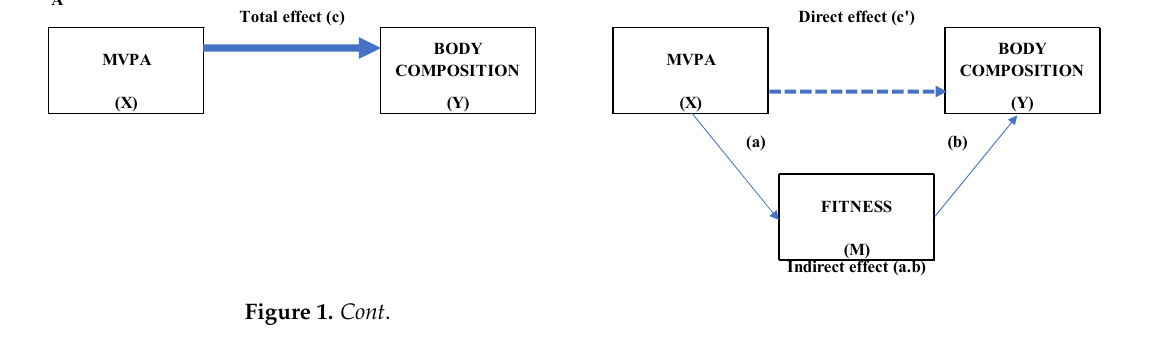
Figure 1. Conceptual models of mediation analysis: indirect effect through fitness ( A ) or kcal ( B ). 3. Results Data for 236 students (59.3% female) aged 16.1 ± 0.92 years that presented valid ac- celerometry data were available for analysis (Table 1). Overall, the bivariate analyses demonstrate consistent small to medium significant relationships between the variables. Regarding body composition, despite 82% of the students presenting with a normal weight, 33% are at high risk according to their body fat. Data from physical fitness assess- ment show that most students were at a low CRF level (71%), and only 23% showed a low muscular fitness level. Triaxial accelerometers data revealed that participants spent an average of 842.4 min per day on sedentary behaviors, 139.6 min per day on light PA, 23.0 min per day on moderate PA, and 13.6 min per day on vigorous PA. Boys had more time on vigorous PA than girls ( p < 0.001). Only 8% of the students performed the recom- mended minutes of MVPA (at least 60 min per day). Regarding body composition and physical fitness, the associations among the study variables showed less correlations for PA below MVPA. Regarding the risk thresholds presented in Table 1, bivariate correlation results showed, for body fat, a negative corre- lation with energy intake (ρ = −0.146, p < 0.05), CRF (ρ = −0.790, p < 0.01), upper body muscle force (ρ = −0.687, p < 0.01), vigorous PA (ρ = −0.400, p < 0.01), and MVPA (ρ = −0.341, p < 0.01). Thus, regarding physical fitness, CRF and strength, respectively, they showed positive correlations with energy intake (ρ = 0.269, p < 0.01; ρ = 0.256, p < 0.01), basal met- abolic rate (ρ = 0.383, p < 0.01; ρ = 0.314, p < 0.01), vigorous PA (ρ = 0.482, p < 0.01; ρ = 0.400, p < 0.01), and MVPA (ρ = 0.347, p < 0.01; ρ = 0.310, p < 0.01), and a negative correlation between CRF and sedentary behavior (ρ = −0.139, p < 0.05). Light or moderate PA did not reveal any correlation with energy intake, physical fitness, or body composition. Seden- tary behavior showed a negative correlation with energy intake (ρ = −0.136, p < 0.05), lean body mass (ρ = −0.177, p < 0.01), and basal metabolic rate (ρ = −0.144, p < 0.05). Correlations among the study variables are presented in Table 2.